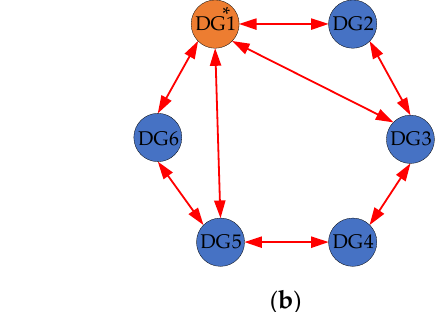
( c ) Figure 21. Change curves of variables of the system under the communication topology of low al- gebraic connectivity: ( a ) change curves of each DG’s ICR; ( b ) change curves of each DG’s active output and grid output power; ( c ) change curves of the cumulative sum of each DG’s active output and grid output power as well as total demand power. ( a ) ( c ) Figure 22. Change curves of variables of the system under the communication topology of high algebraic connectivity: ( a ) change curves of each DG’s ICR; ( b ) change curves of each DG’s active output and grid output power; ( c ) change curves of the cumulative sum of each DG’s active output and grid output power as well as total demand power. It can be seen from Figures 19, 21, and 22 that the ICR of each DG is rapidly converged to the optimal ICR by right of the improved pinning consensus algorithm based on ICR, which is identical to the grid electricity price in the flat-valley period. Thus, the total op- eration cost of the grid-connected microgrid system is minimized. Additionally, the eco- nomic distribution of active output is realized by each DG. The power of DGs is supplied to the load together with the grid power, thus meeting the total power demand of users of 125 kW. The simulation results have shown that the superior dynamic and steady-state